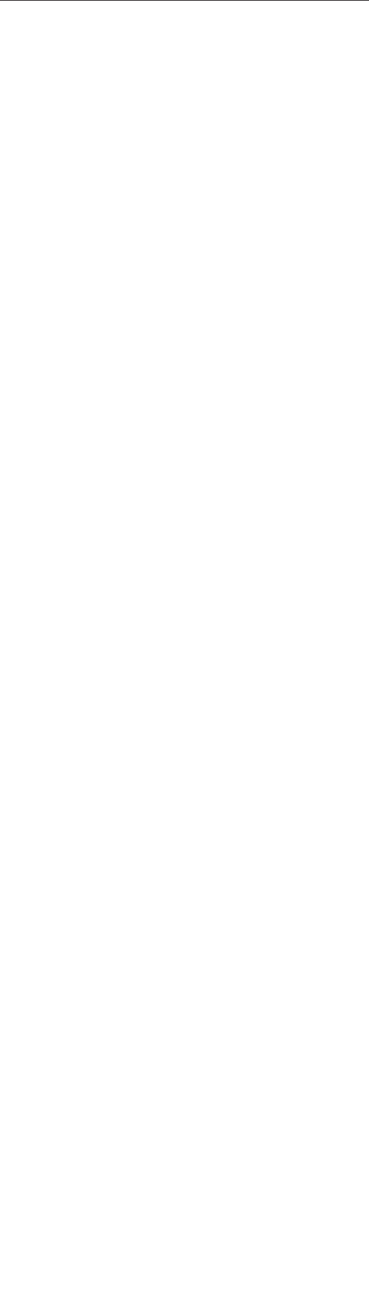
FIGURE 5 | The sensory neurons of AEW-treated mice showed increased responses to TSLP, in a TRPV4-dependent manner. (A) Representative calcium imaging fl uorescent responses following the application of 5 ng/mL TSLP to the primary culture of murine DRG neurons of the control mice. The scale bar indicates 50 µm. (B) A time-course graph of TSLP-induced calcium-speci fi c fl uorescence in the DRG neurons from the control mice following treatment with TSLP (n = 10). F denotes the fl uorescence intensity of the region of interest, and F 0 indicates the initial fl uorescence intensity. (C) Representative calcium imaging fl uorescent responses following the application of TSLP in the primary culture of DRG neurons of AEW-treated mice. (D) A time-course graph of TSLP-induced calcium-speci fi c fl uorescence, indicating the responses of the DRG neurons of AEW-treated mice following treatment with TSLP (n = 19). (E) Averaged time-course pro fi les of TSLP- induced responses of the DRG neurons of the control (n = 10) and AEW-treated (n = 19) mice. (F) Pretreatment of the DRG neurons of AEW-treated mice with the TRPV4 antagonist, HC06747, signi fi cantly inhibited the TSLP-induced responses (n = 21), while treatment with the PAR2 antagonist, FSLLRY, produced no changes (n = 5). (G) The TSLP-induced responses of the DRG neurons of Trpv4 -/- mice (n = 39) revealed that the peak responses were signi fi cantly reduced in comparison to those of the control (n = 56). (H) The percentage of TSLP-responsive neurons in Trpv4 -/- mice (3.9%, 39 out of total 989 neurons) was signi fi cantly lower than that of Trpv4 +/+ mice (7.5%, 56 out of total 744 neurons) (Fisher ’ s exact test). Transcriptional levels of both Tslpr (I) and Trpv4 (J) were increased in DRG from AEW-treated mice (n = 3 per group). * p < 0.05, ** p < 0.01, *** p < 0.001, n.s. not signi fi